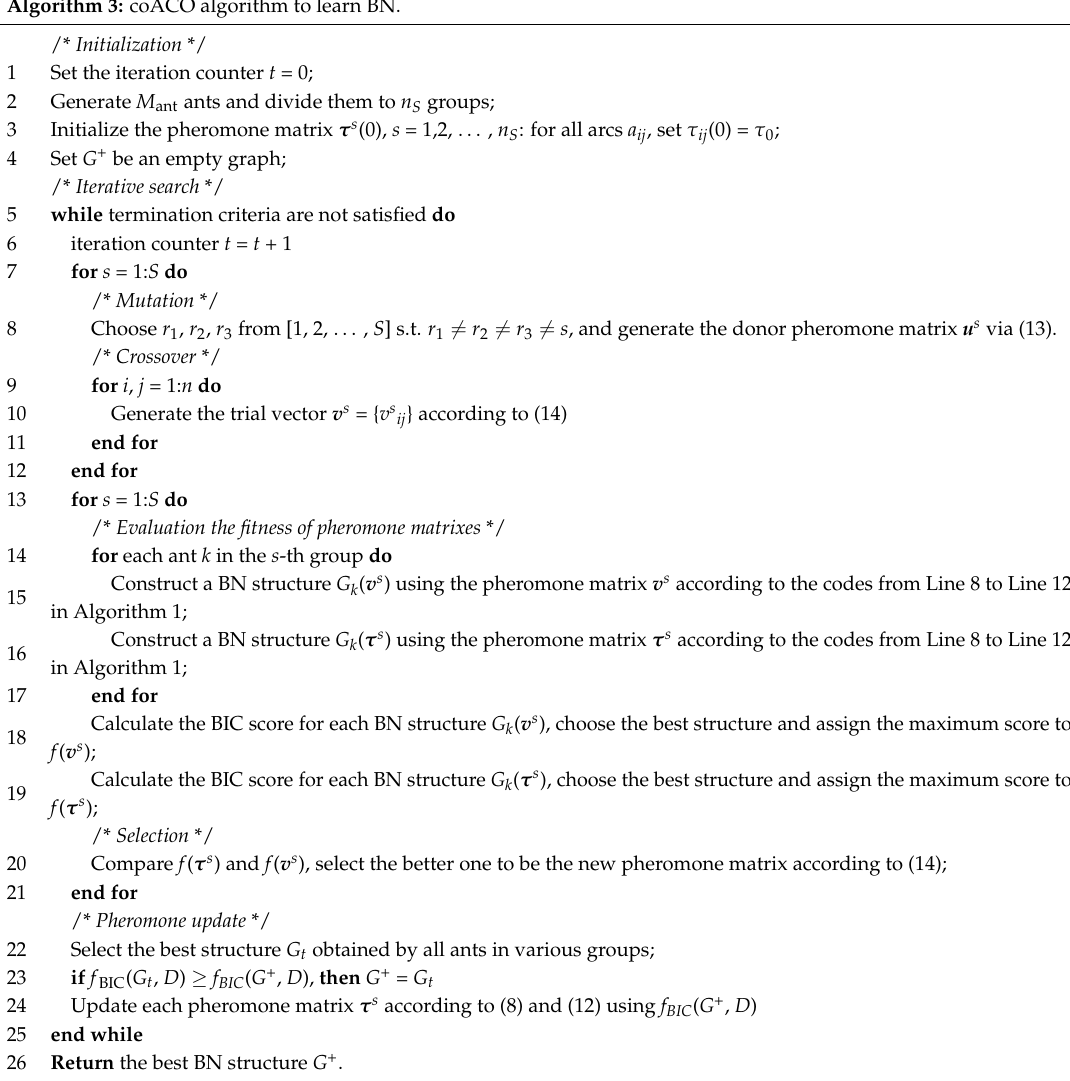
Algorithm 3: coACO algorithm to learn